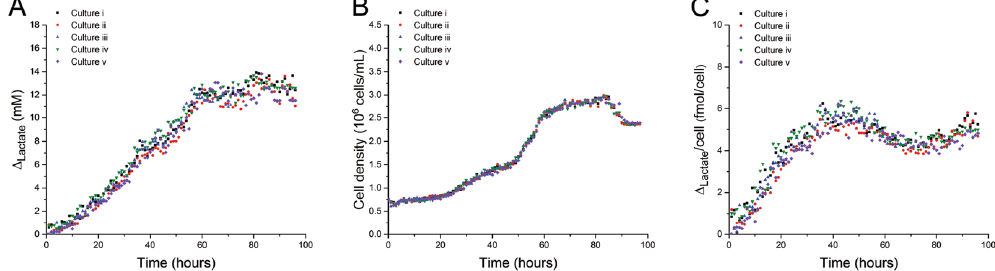
Figure 3. Simultaneous monitoring of 5 parallel cell cultures of Jurkat cells over 4 days. ( A ) Changes in lactate concentration determined using the conditions detailed in Fig. 2, ( B ) Changes in cell density, ( C ) Lactate concentrations standardized on cell density. No significant differences were found between the 5 parallel cultures based on the rate of lactate production per cell per time, ( p values range 0.072–0.791), using one way ANOVA